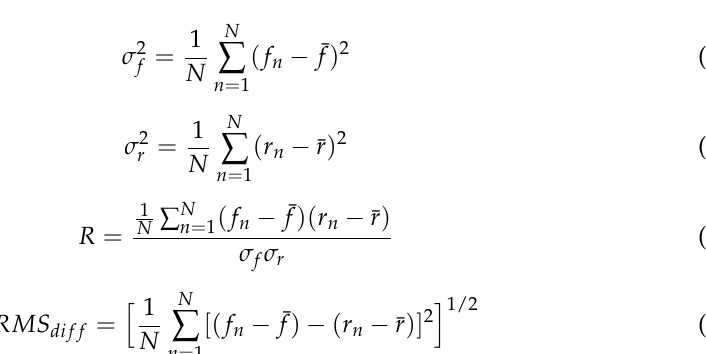
Figure 2. Taylor graph example and its formulation